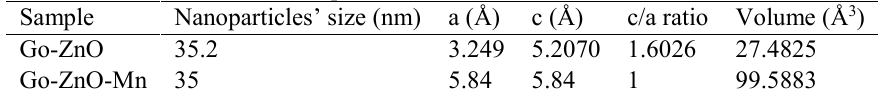
Table 1. Parameters of Nanocomposite network